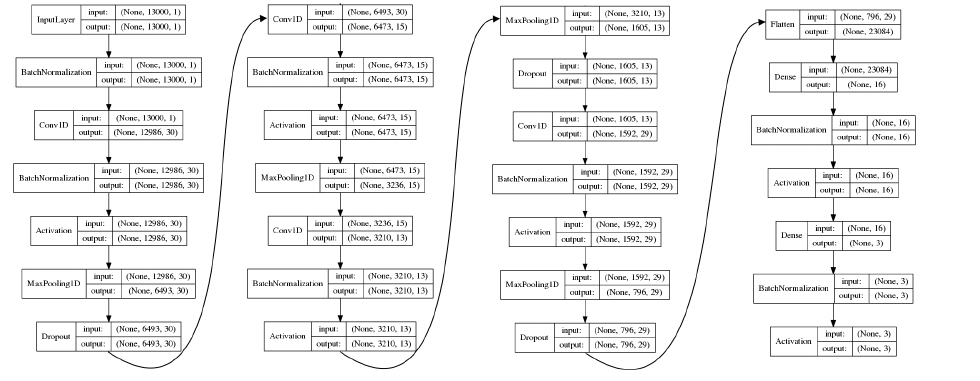
Figure 14: Best CNN with batch normalization architecture on raw traces.